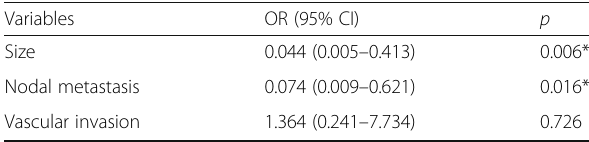
Table 3 Multivariate analysis of clinicopathological data and CD68 positive TAMs within tumor stroma